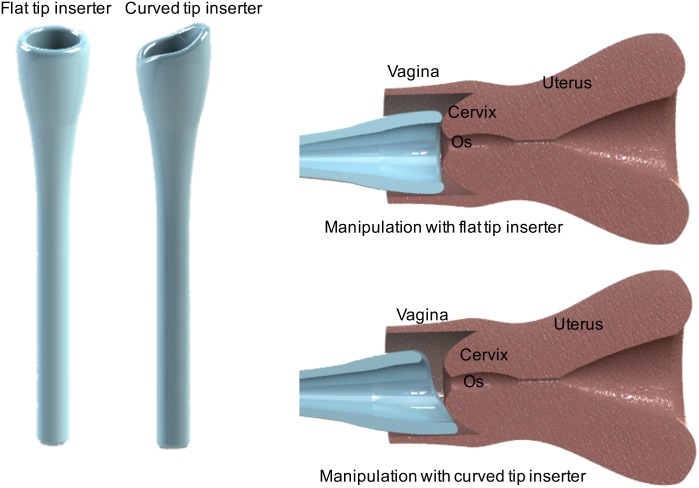
Original flat tip inserter and optimized curved tip probe inserter.Images of the devices inserter into the vagina show how the curved tip of the optimized inserter enables manipulation of the cervix.